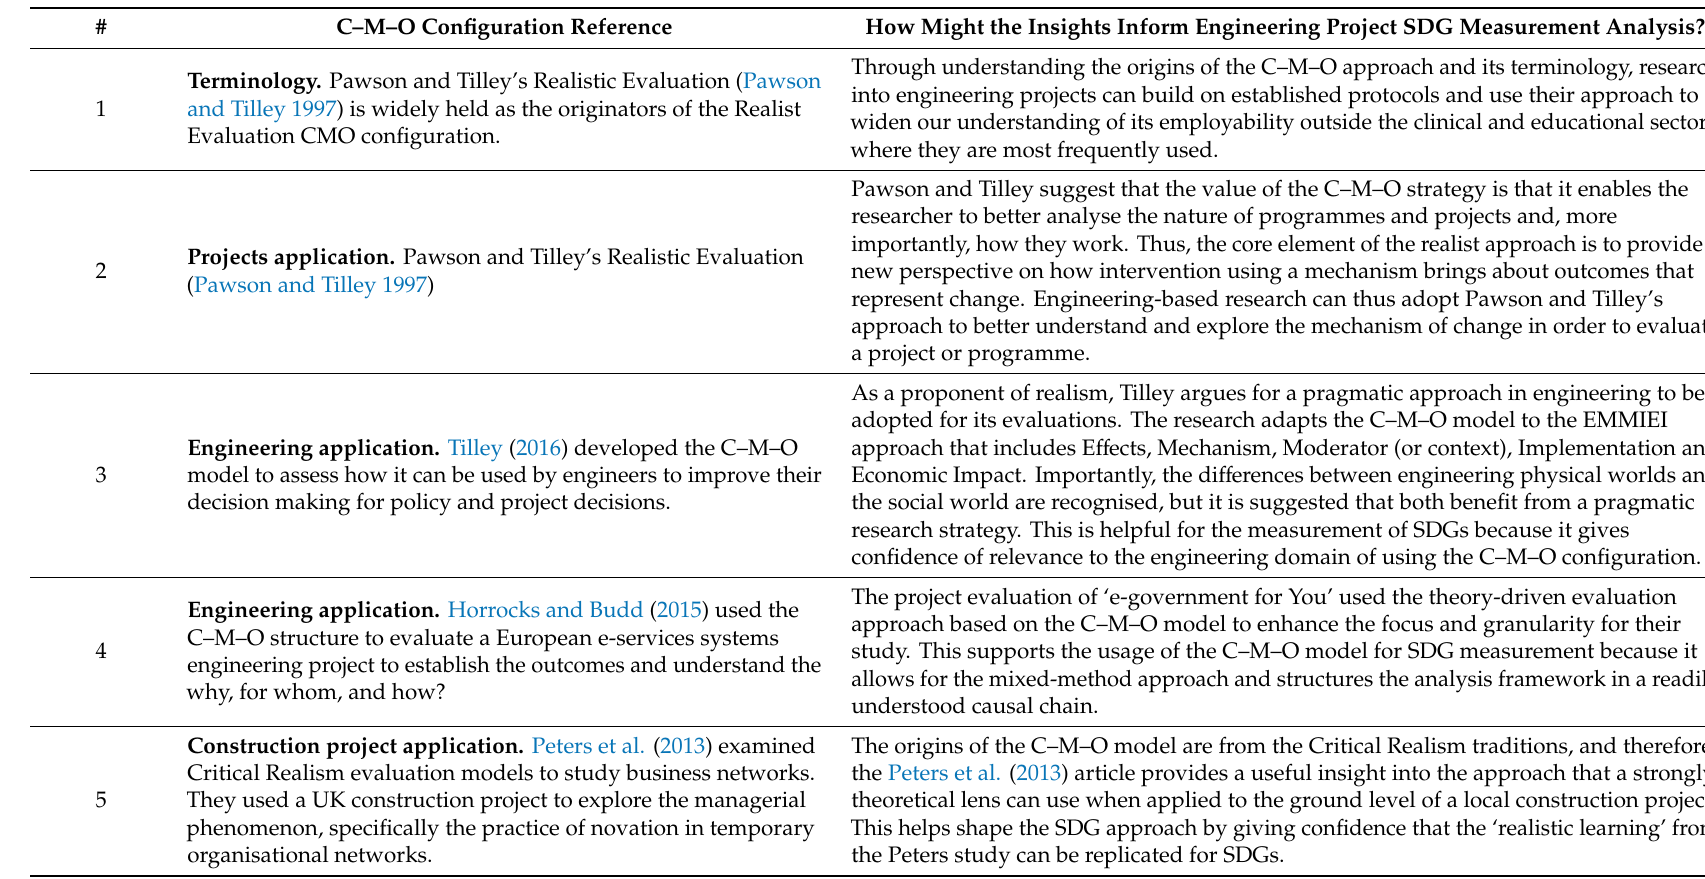
Table 1. Examples of the use of Critical Realism and Realist Evaluation C–M–O configuration that informs similar use on evaluation of phenomena on engineering